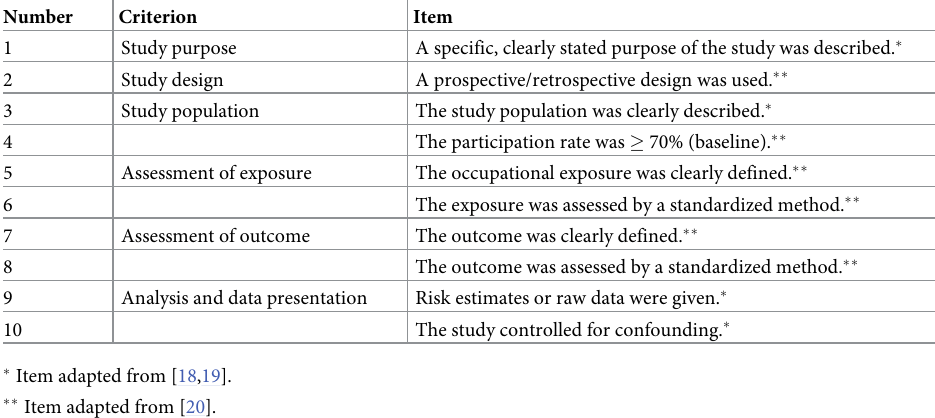
Table 1. Checklist for the quality assessment of studies analyzing MSDs/MSP among dental